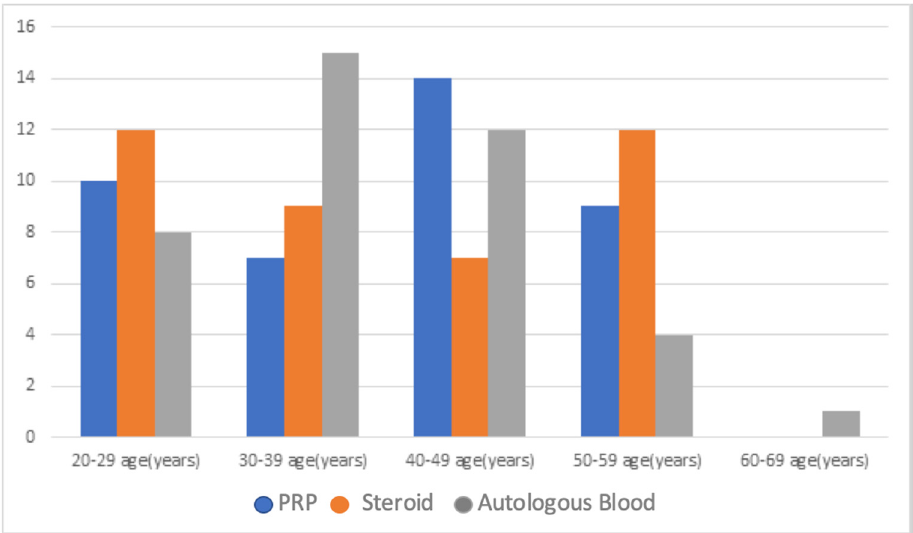
Figure 1. Distribution of patient groups by age.